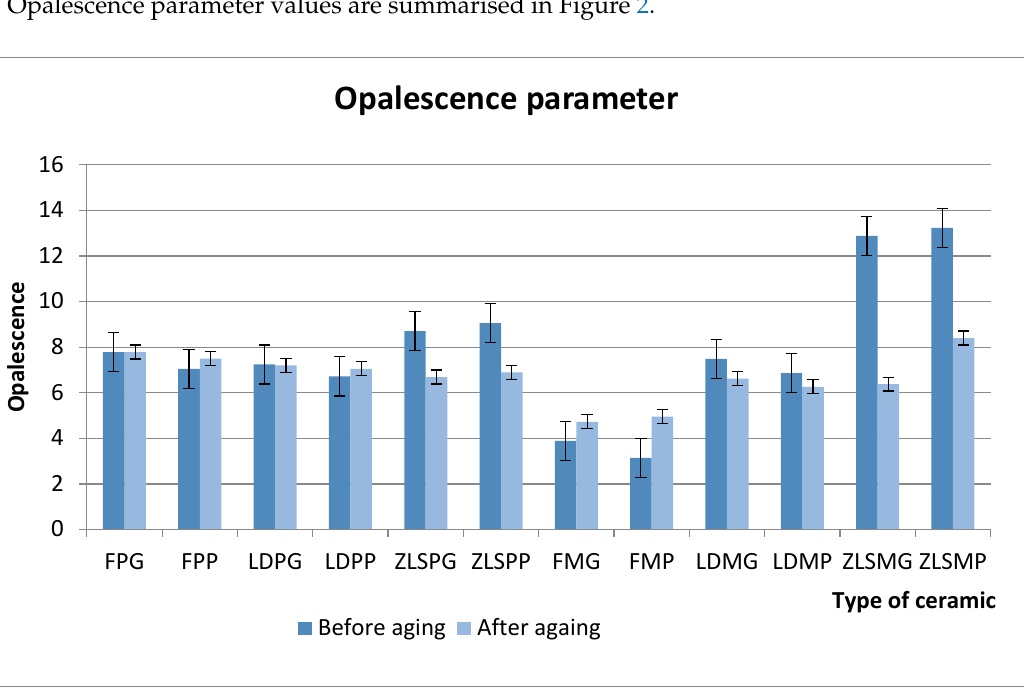
Figure 2. Mean values for the opalescence parameter before and after thermocycling for the hot-pressed and milled ceramics. Table 6. Mean values for OP parameter.